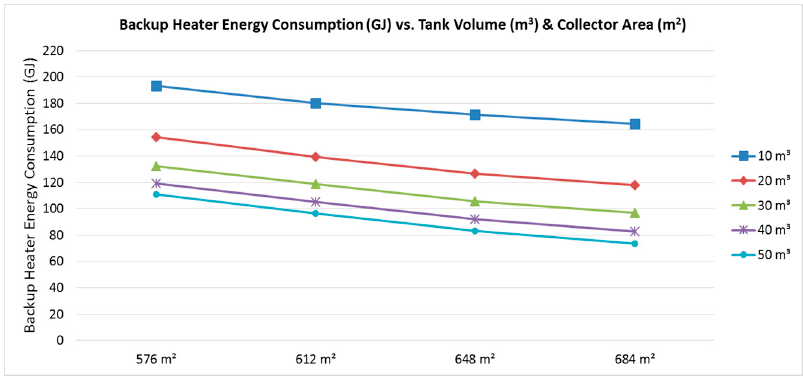
Figure 15. The impacts of tank volume and collector area on annual backup heater energy consumption.